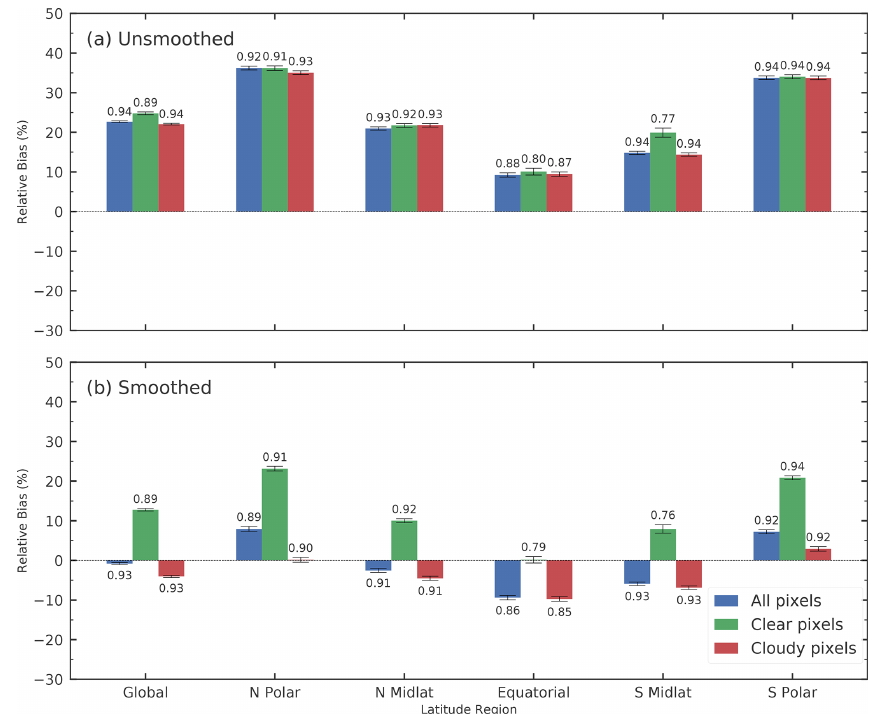
Figure 5. Summary of the relative differences between TROPOMI and ACE-FTS for (a) the unsmoothed and (b) smoothed comparisons for all TROPOMI pixels (qa_value ≥ 0 . 5; blue bars), clear pixels only (qa_value = 1 . 0; green bars), and cloud-covered pixels only (0 . 5 ≤ qa_value ≤ 0 . 7; red bars). The error bars correspond to the standard errors of the mean, and the values above and below the error bars are the Pearson correlation coefficients for that particular case and latitude